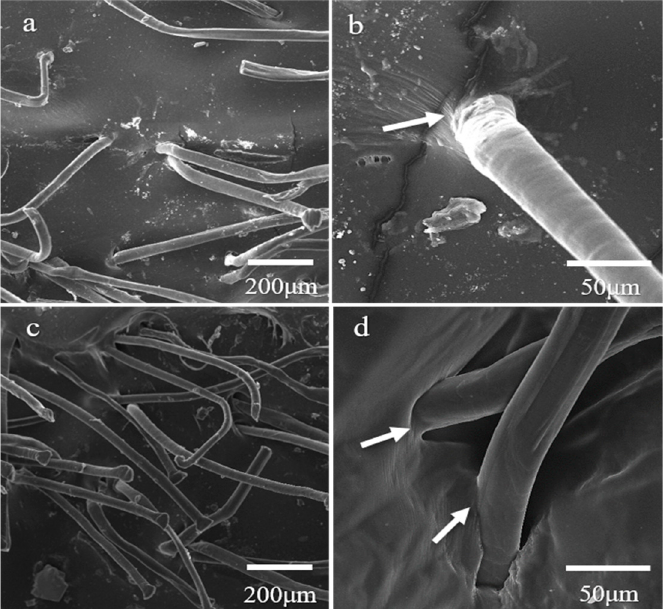
Figure 4. SEM images of the cross-section of the NR filling with 2 phr ( a , b ) and 4 phr ( c , d ) of UHMWPE short fibers (2 cm length).